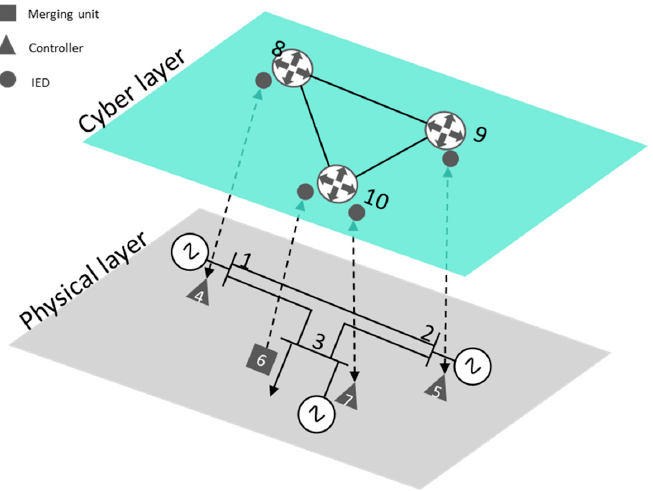
Figure 4. A three-buses cyber-physical network representation.